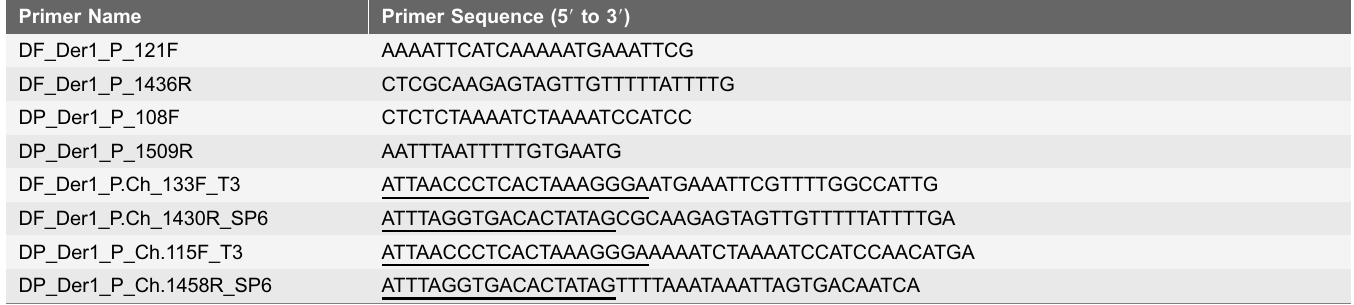
Table 1. Species-specific oligonucleotide primers used in nested amplification of the group 1 allergen gene (Der f 1 and Der p